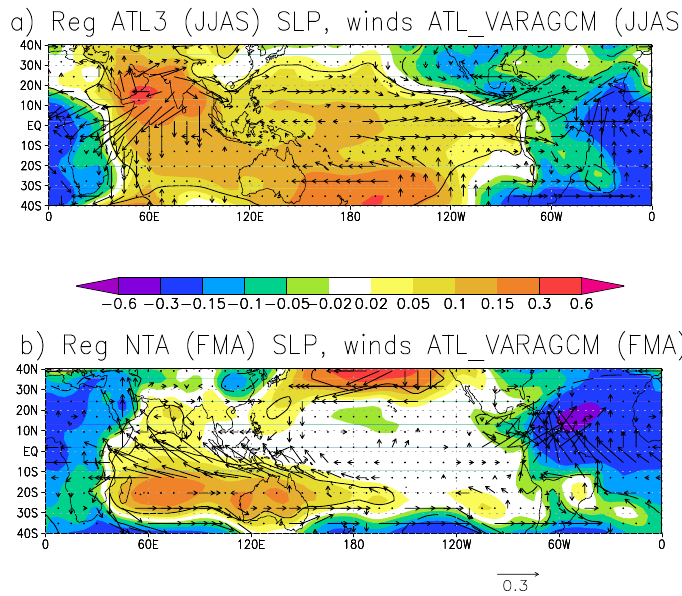
Figure 7. Regression contemporaneous of ATL_VARAGCM SLP and low-level winds onto ( a ) ATL3 index (JJAS) and ( b ) NTA index (FMA). SLP anomalies that are 95% statistically significant are indicated by contours, and only statistically significant wind vector components are shown. Units are hPa for SLP and m/s for